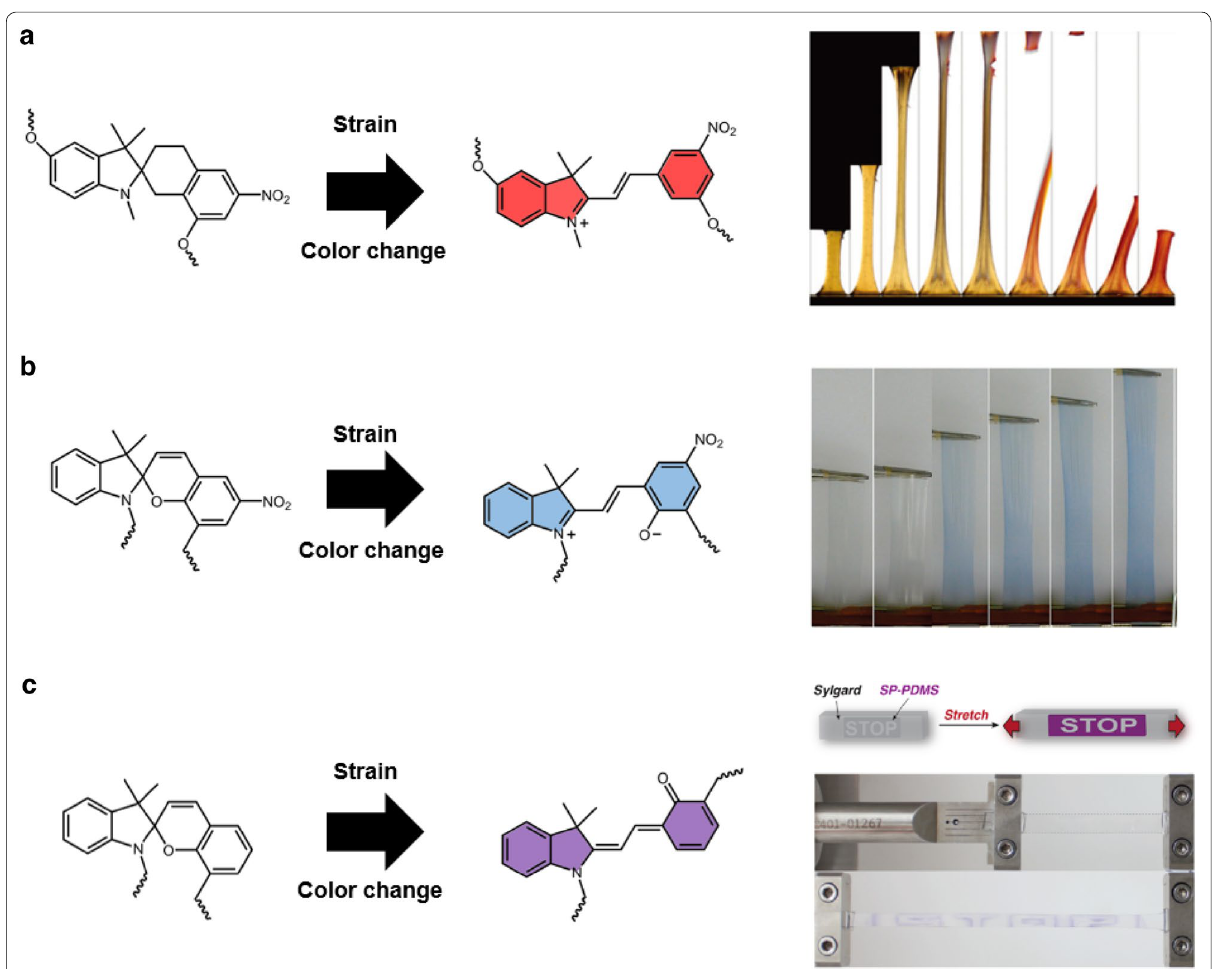
Fig. 6 Mechanochromic spiropyran based polymers that change color after stretching. a Spiropyran(SP) embedded poly(methyl acrylate) exhibits color change from yellow to red by ring opening reaction induced by applied strain. b Indolinospiropyran‑poly(e‑caprolactone) films turned to blue colored merocyanine form by mechanical force‑induced bonds rearrangements. c Spiropyran embedded PDMS elastomer is patterned on a PDMS substrate and show a word “STOP” after a deformation (Figure reproduced from a [50], Copyright 2009, Springer Nature; b [51], Copyright